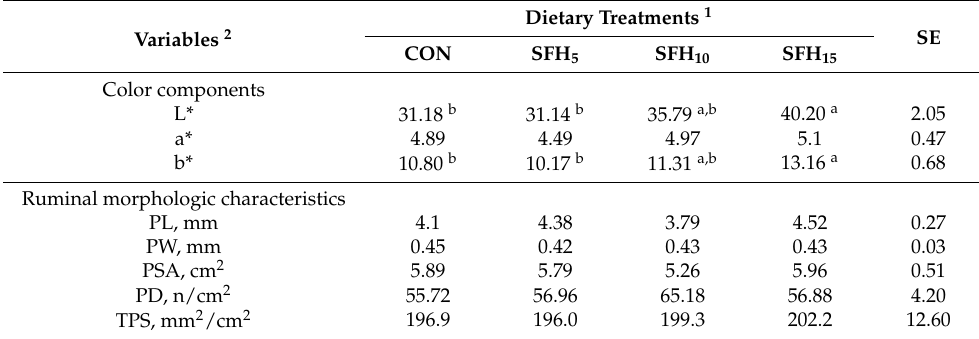
Table 7. The ruminal color values and morphology of growing lambs fed the experimental diets containing different levels of sunflower